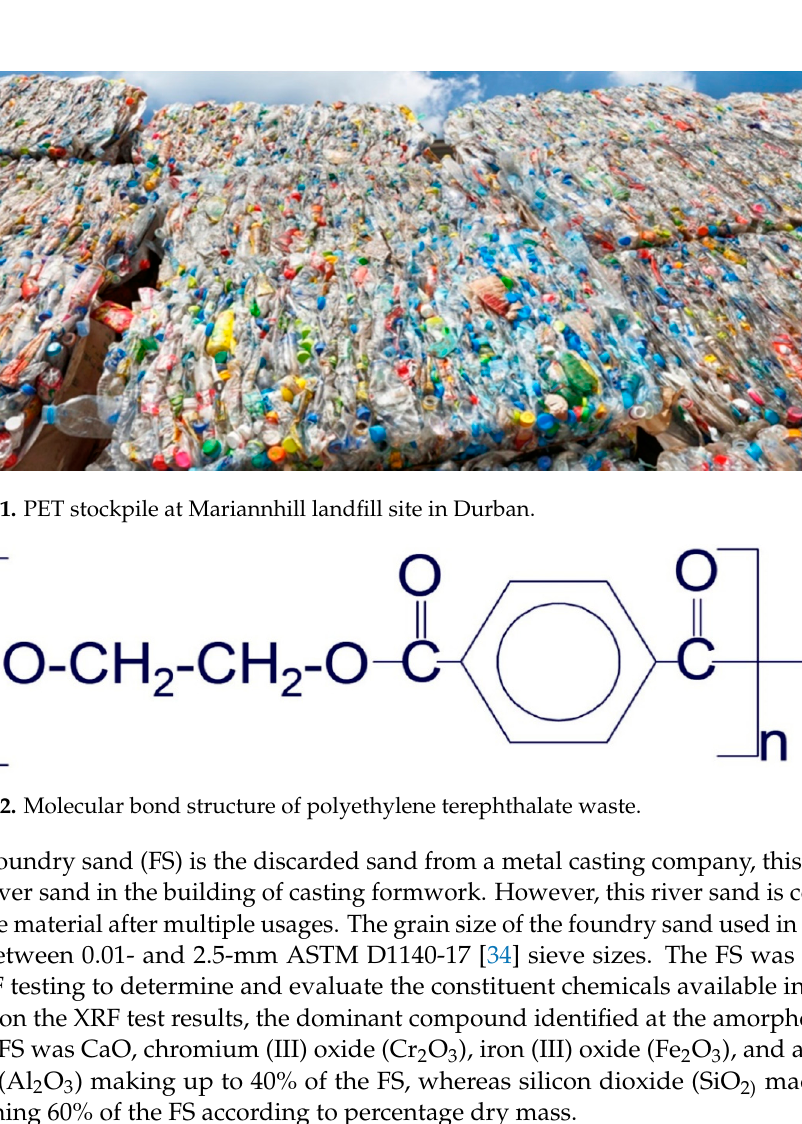
Figure 2. Molecular bond structure of polyethylene terephthalate waste.